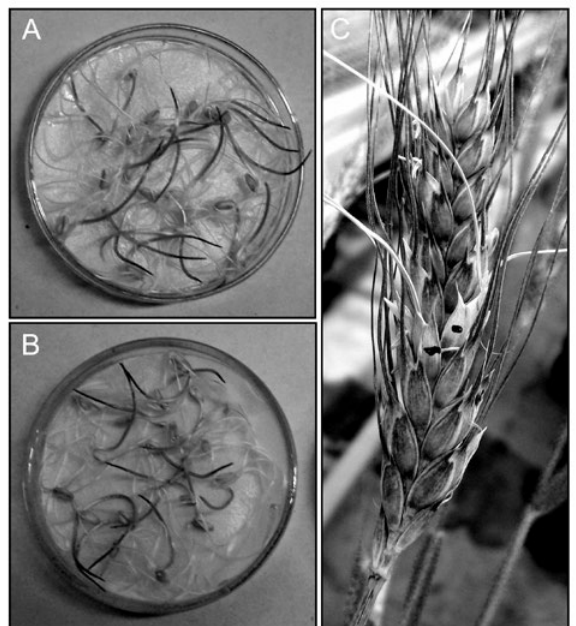
Figure 1. Seedlings and head of Langdon-Dic3A durum wheat. Six-d-old seedlings in control (water) ( A ) and Fusarium graminearum -inoculated ( B ) treatments. Dam- aged spikelets at 21 dpi ( C ).